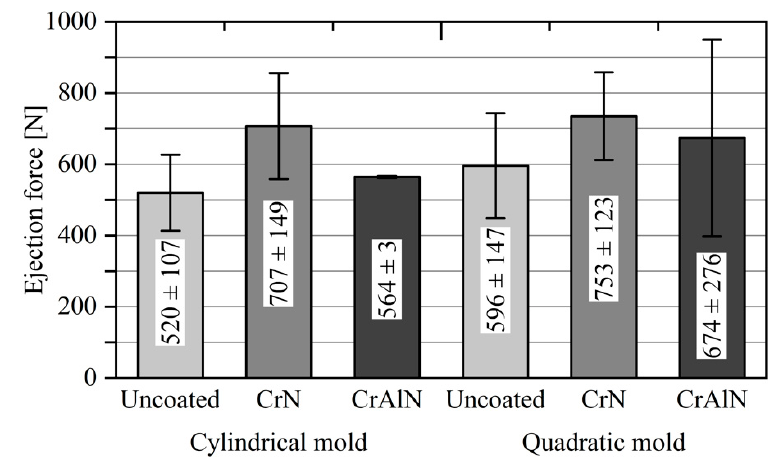
Figure 8. Ejection forces of uncoated and CrN and CrAlN coated molds.